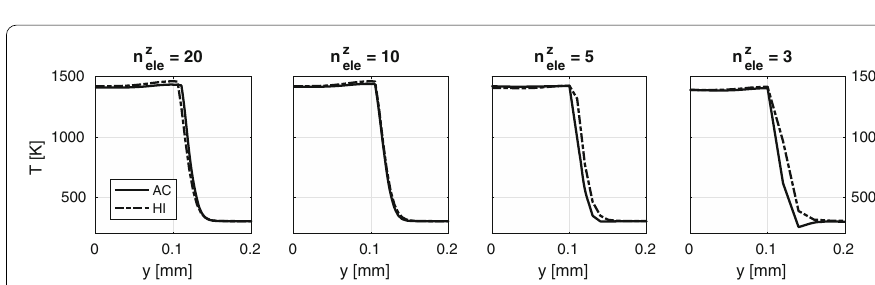
Fig. 19 Surface temperature profiles for AC and HI transverse to laser path at x = 0 . 4mm showing transition from melt pool to powder